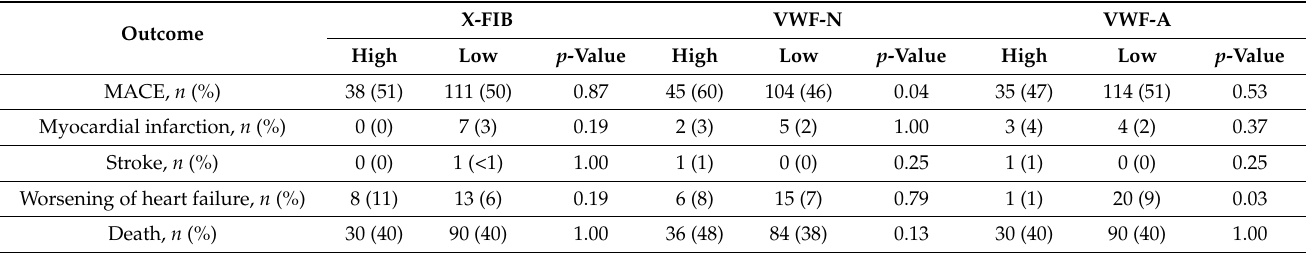
Table 2. Distribution in outcome for high (upper quartile) versus low (lower three quartiles) levels of each